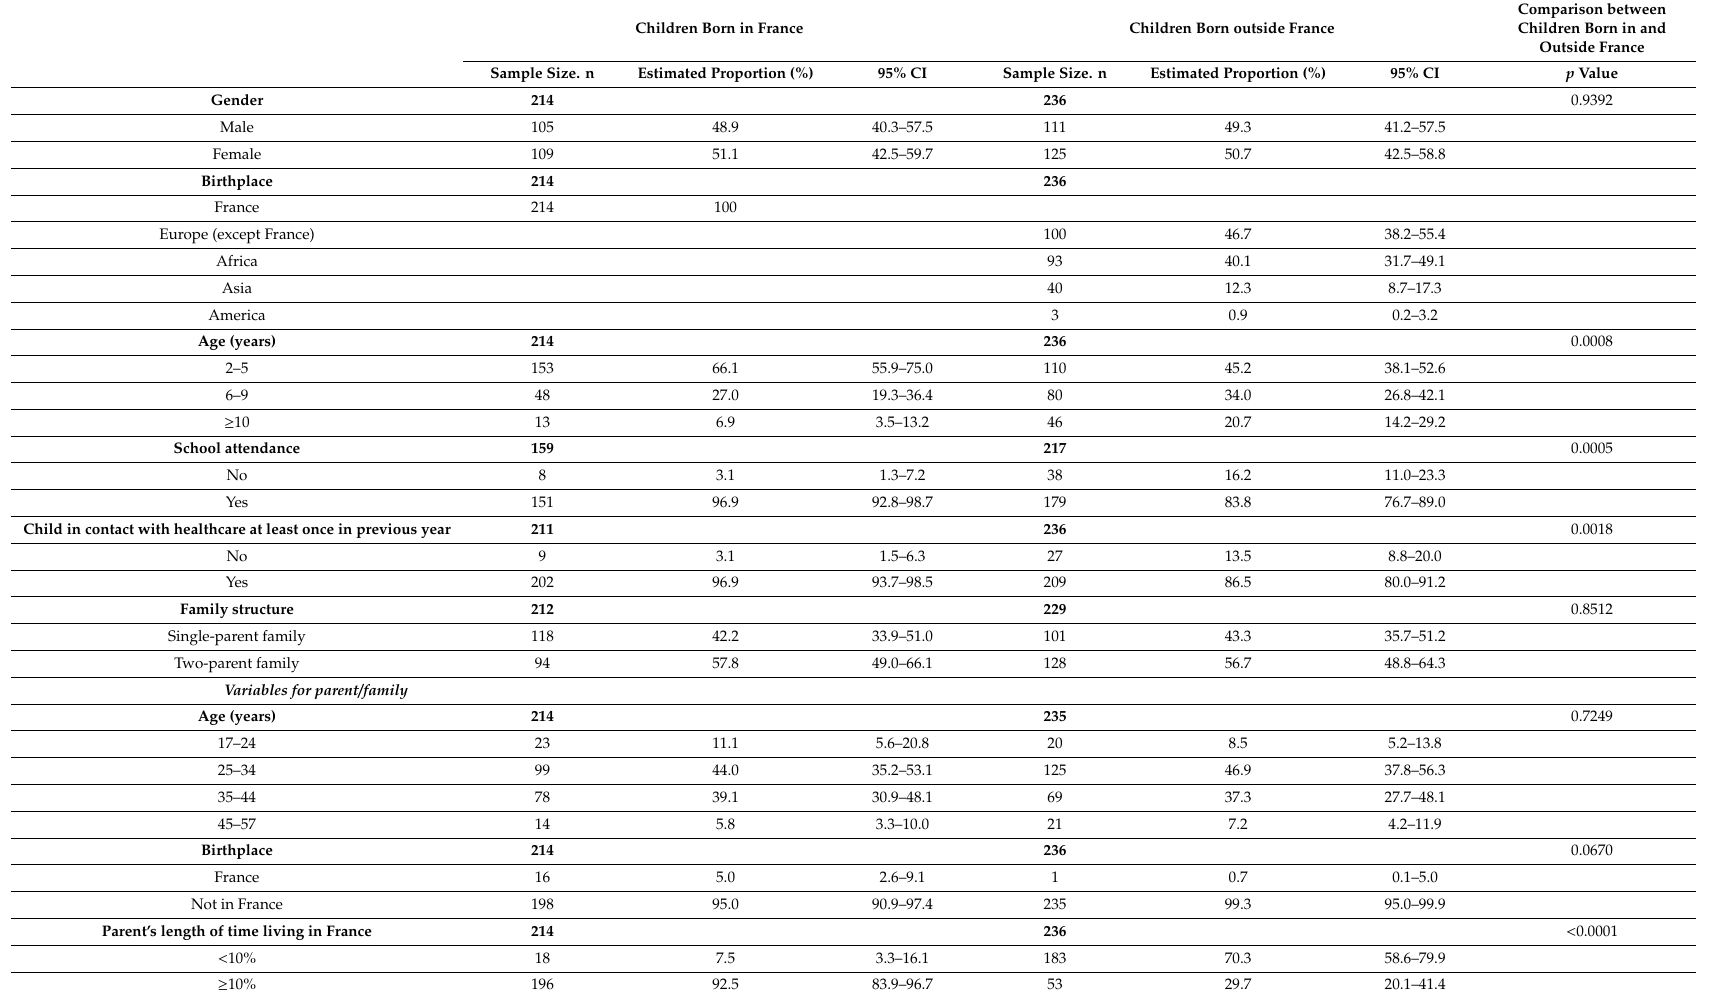
Table 1. Characteristics of homeless children in the sample ( n = 450) and estimated as a percentage of characteristics according to birthplace. Children Born in France Children Born outside